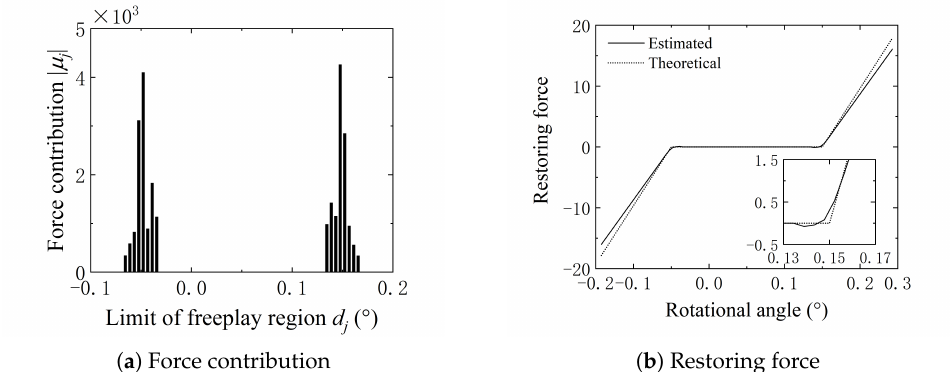
Figure 15. The identification of offset freeplay using the 2nd displacement range.